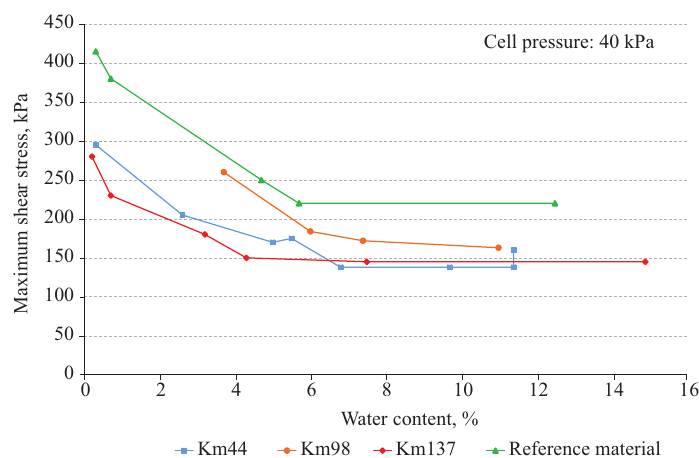
Figure 4. The achieved maximum shear stresses of the static triaxial tests at varying moisture content levels